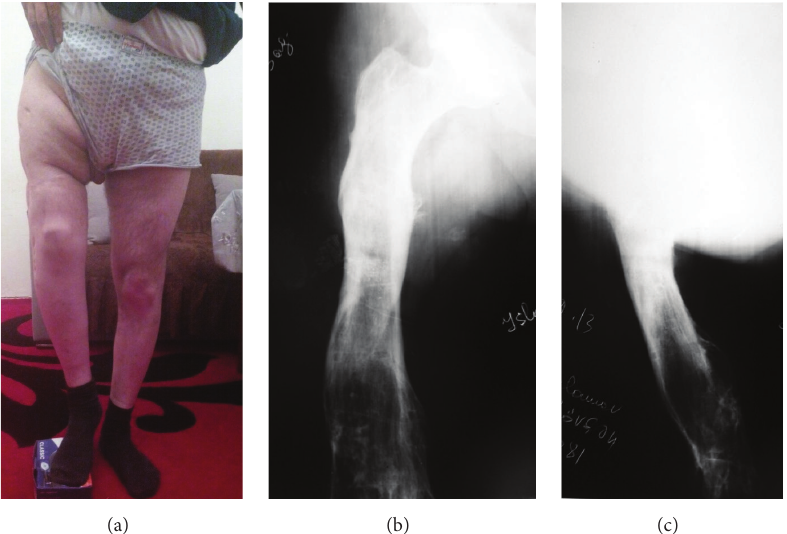
Figure 3: The patient was free of osteomyelitis and was able to walk with 4cm shortness in the right lower extremity 7 years postoperatively. (a) Clinical appearance. (b, c) AP and lateral X-rays of the right femur seven years